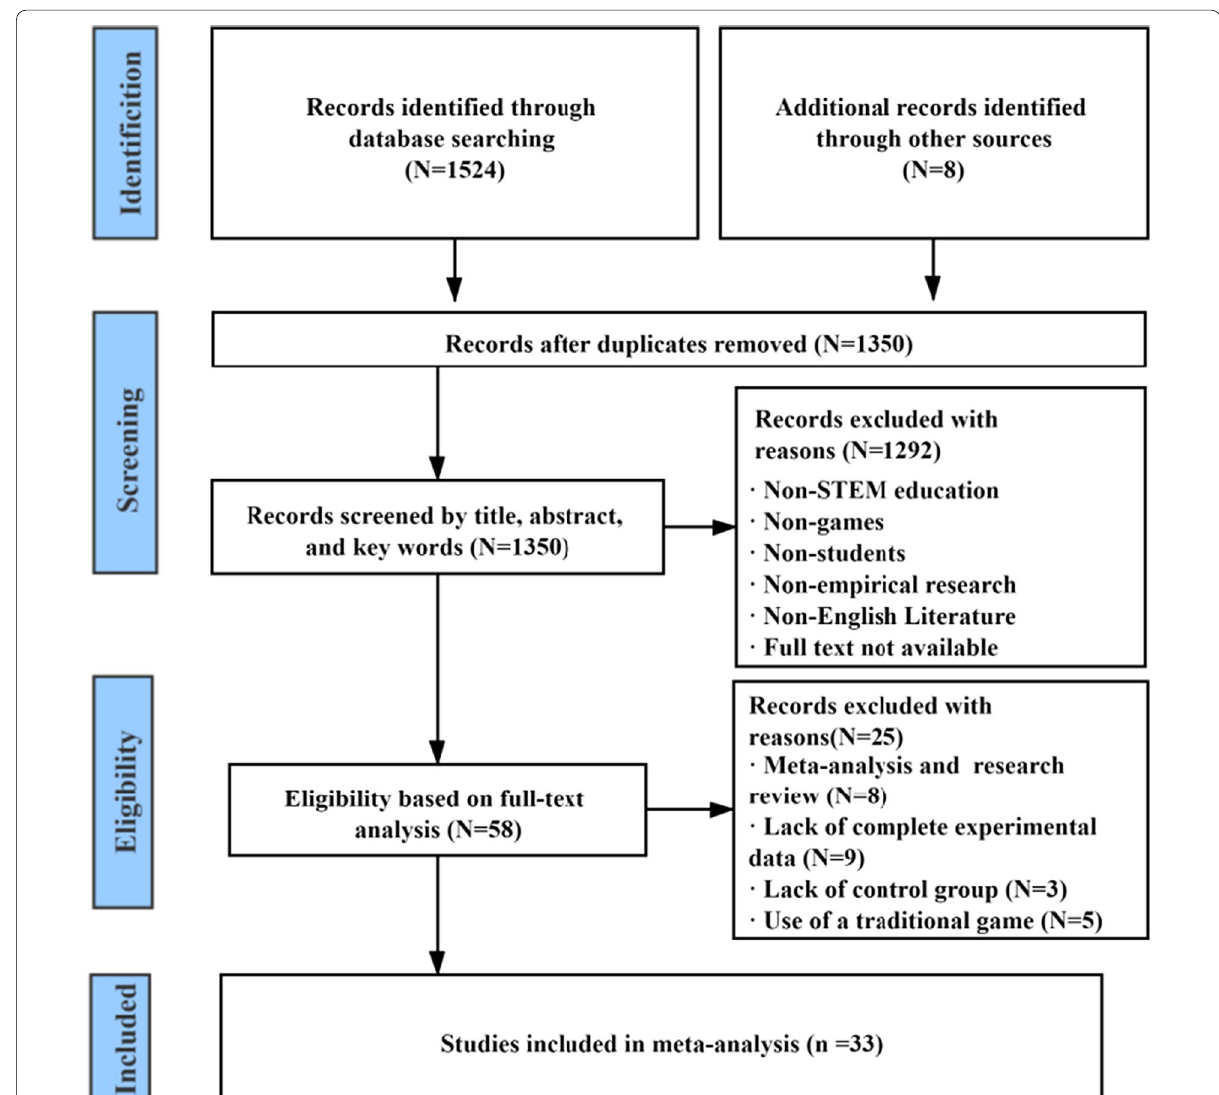
Fig. 1 PRISMA flow diagram of data